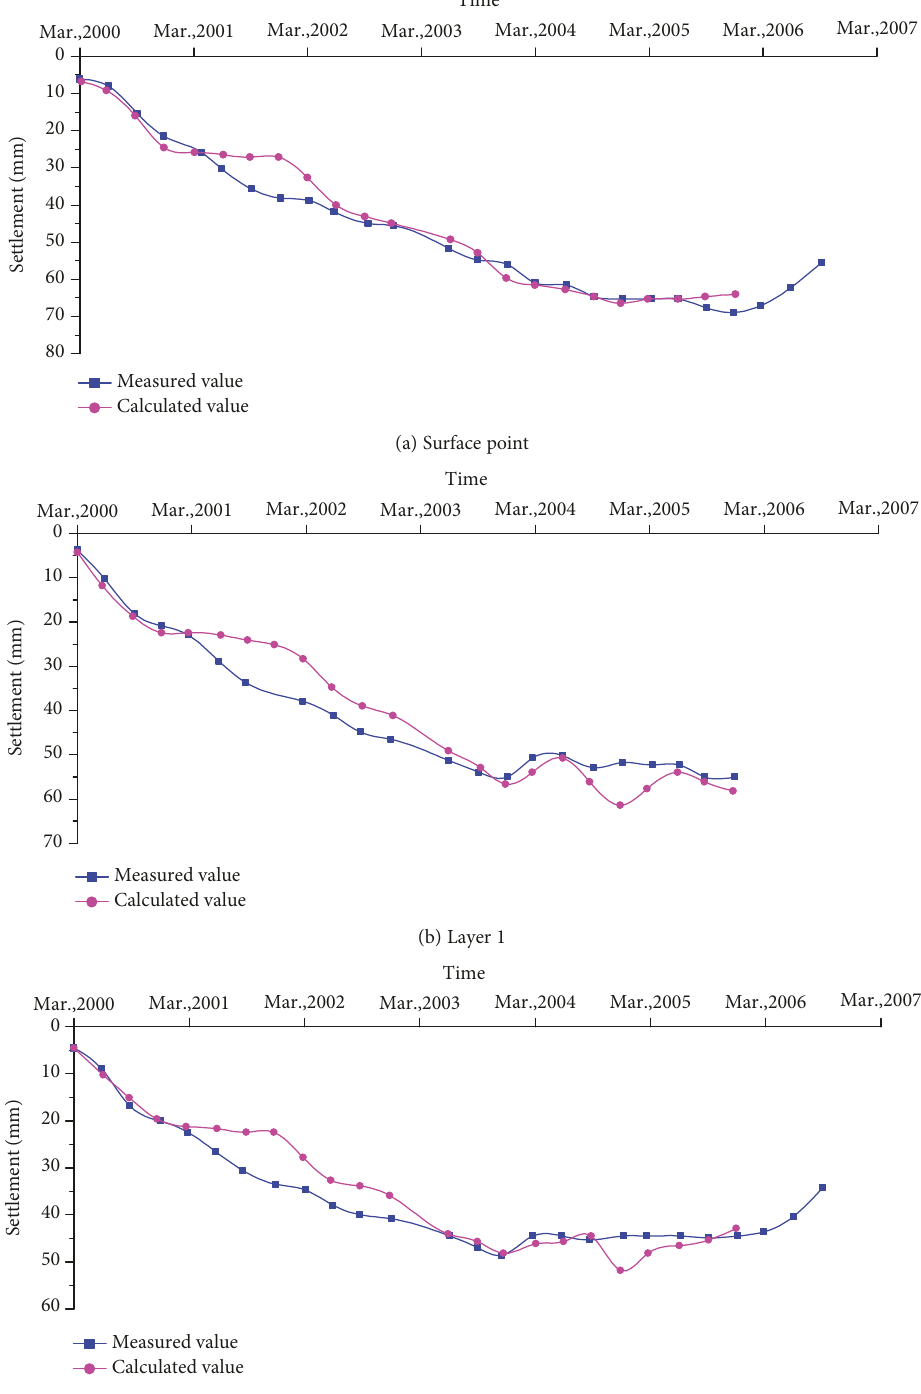
Figure 7: Comparison between measured and calculated settlements of soil